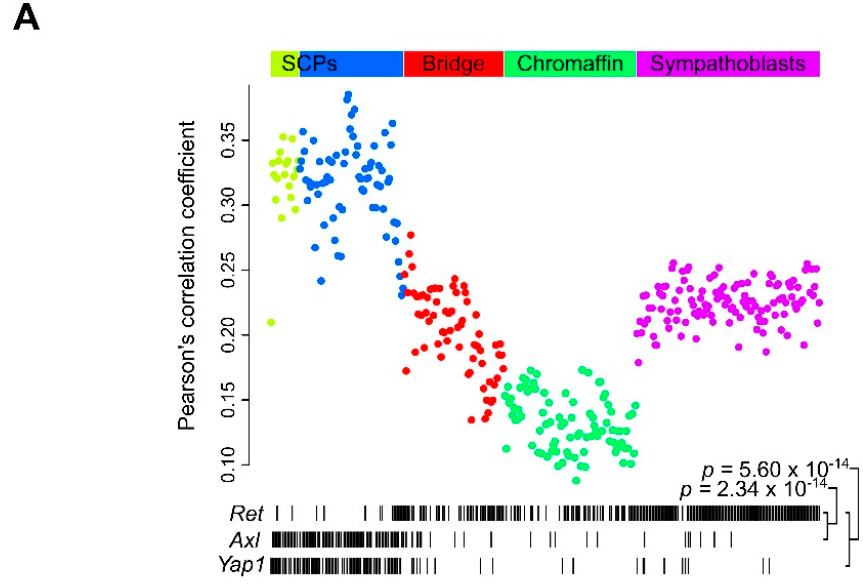
Figure 7. RET inhibits MES signature genes in SK-N-AS cells. ( A ) Western blot analysis of expression of selected MES signature proteins as indicated in RET CRISPR/Cas9 engineered SK-N-AS cells. ( B ) Knockdown of RET by small interfering RNA (siRNA) in SK-N-AS cells led to increased expression of AXL protein, whereas restored expression of RET in RET KO clones led to a trend in decreased expression of MES signature proteins ( C ). ( B , C ) Arrowheads indicate two bands of RET protein; arrow indicates AXL. Fibronectin 1 (FN1), MNNG HOS transforming gene (MET), Yes-associated protein (YAP).